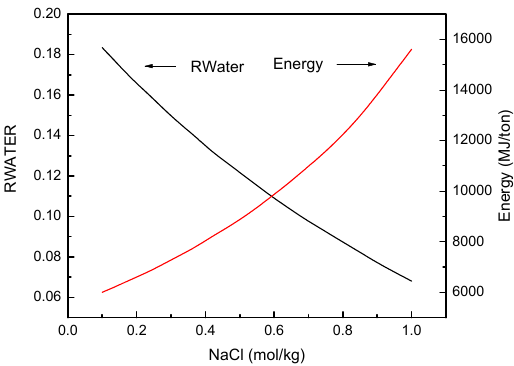
Figure 10. The effect of feed solution concentration on the FO process performance using PB as the draw solute.